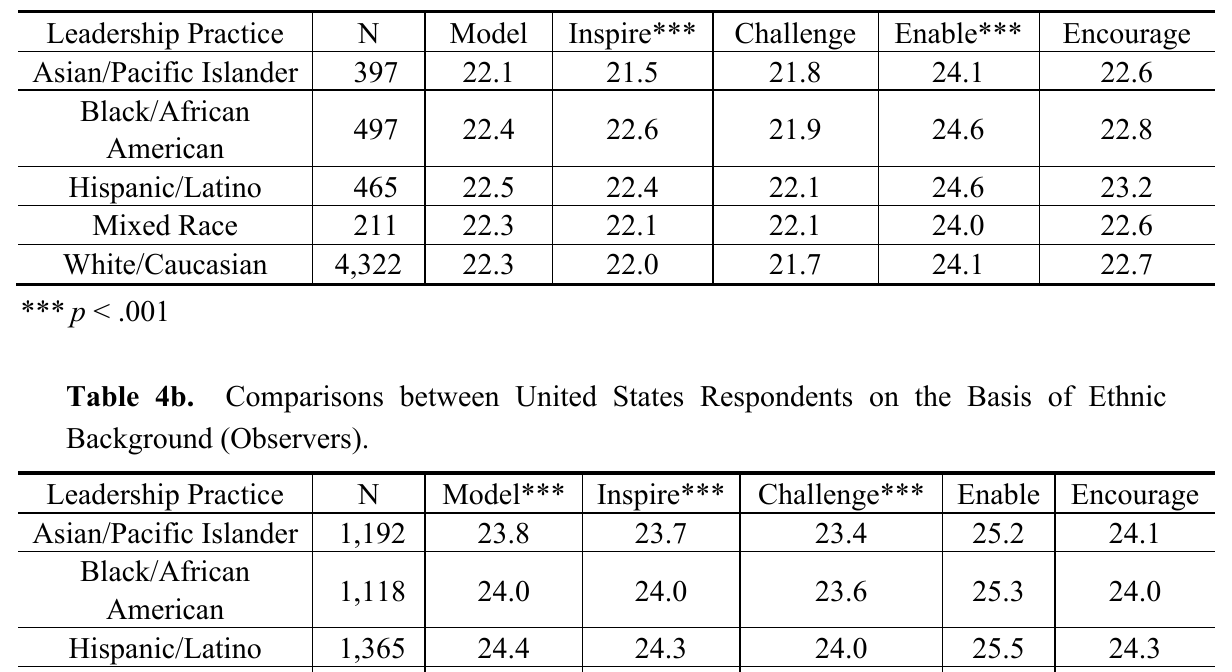
Table 4a. Comparisons between United States Respondents on the Basis of Ethnic Background (Self).